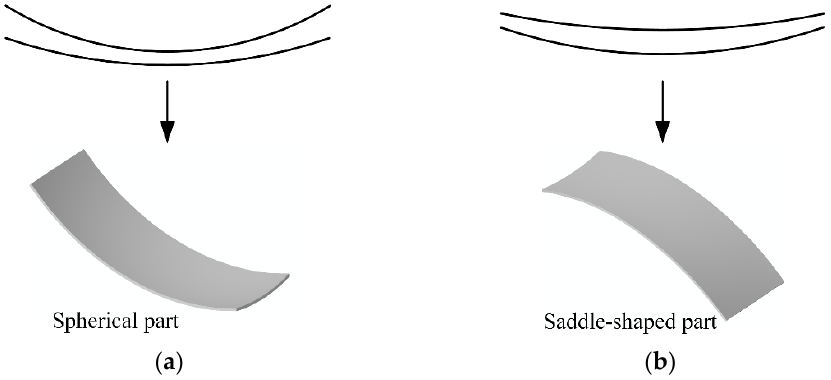
Figure 2. Two typical 3D curved parts and their corresponding roll gap—( a ) roll gap 1; ( b ) roll gap 2.